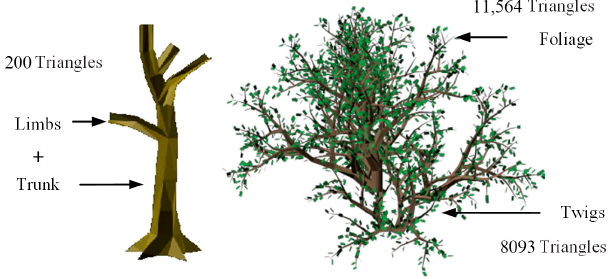
Figure 1. Graphics-based method (200 triangles for the solid part, i.e., trunk and limbs, and 19,657 triangles for the sparse part, i.e., foliage and twigs, by Jakulin [15]).